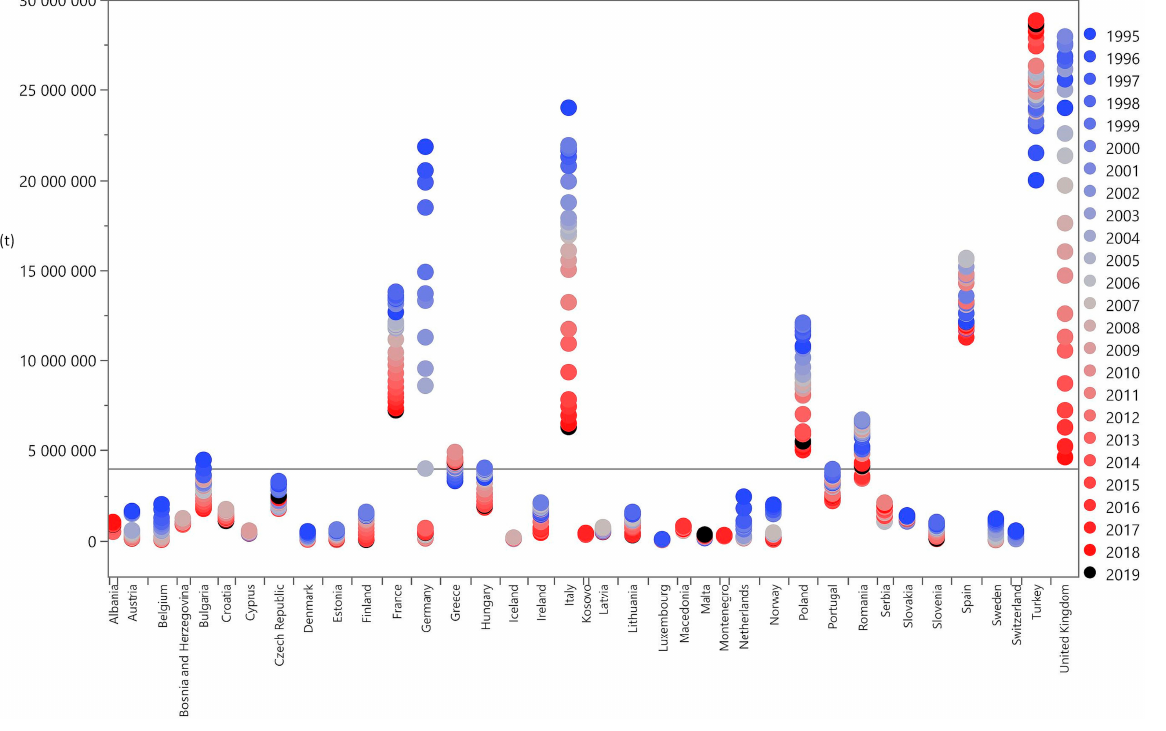
Figure 9. Landfill use in EU countries.